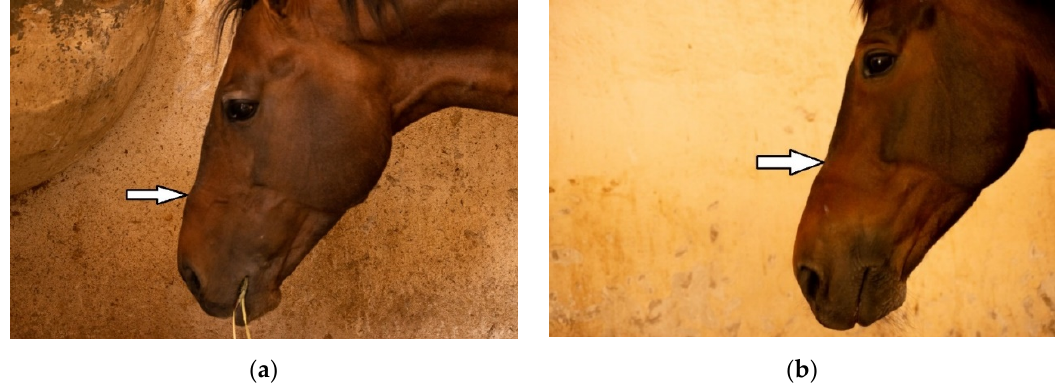
Figure 1. Photograph of profile of horse in which examiners ( n = 2) agreed there was confirmed: ( a ) exostosis and ( b ) concavity in the nasal bones. Photographs courtesy of Missael Garc í a-M á rquez.